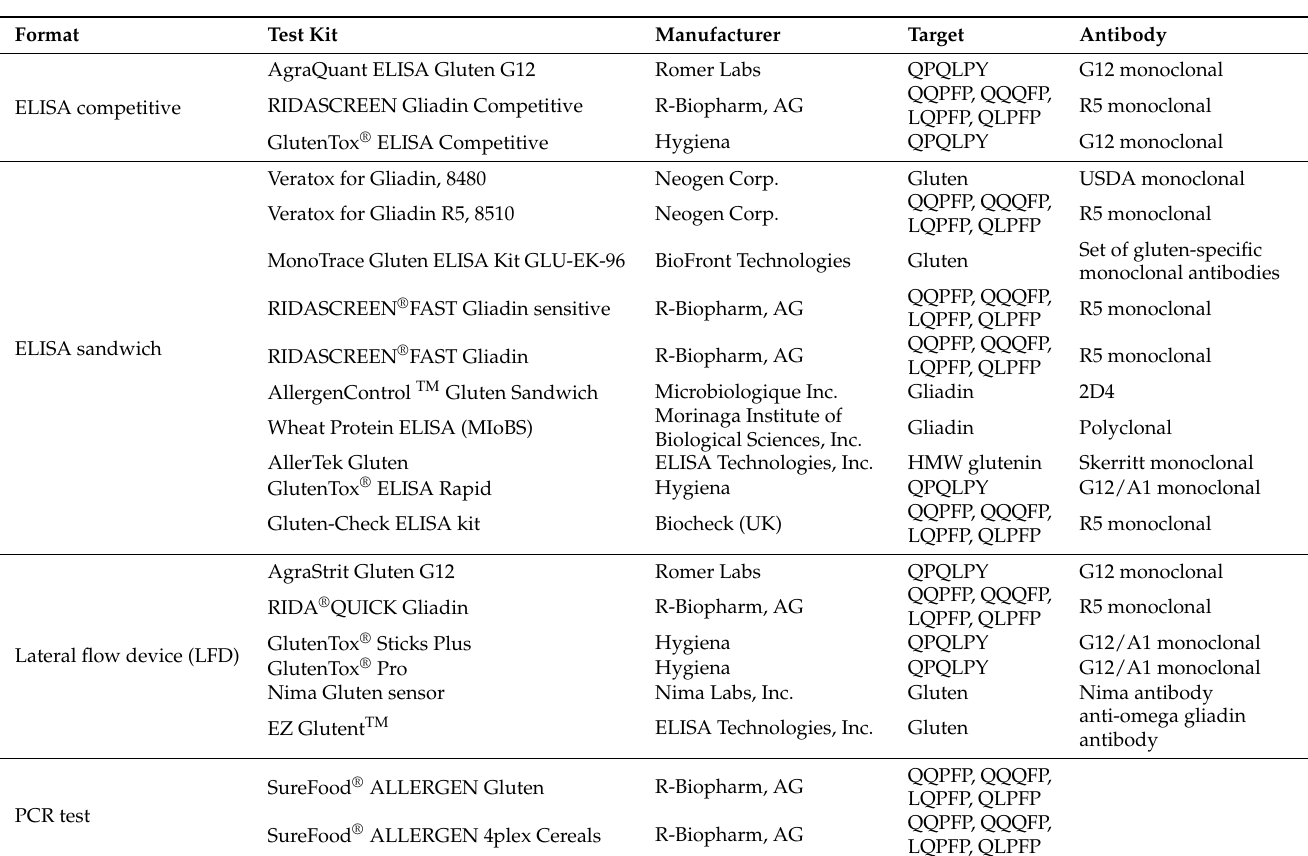
Table 3. Gluten-specific methods commercially available worldwide. ELISA, Enzyme-Linked ImmunoSorbent Assay; PCR, polymerase chain